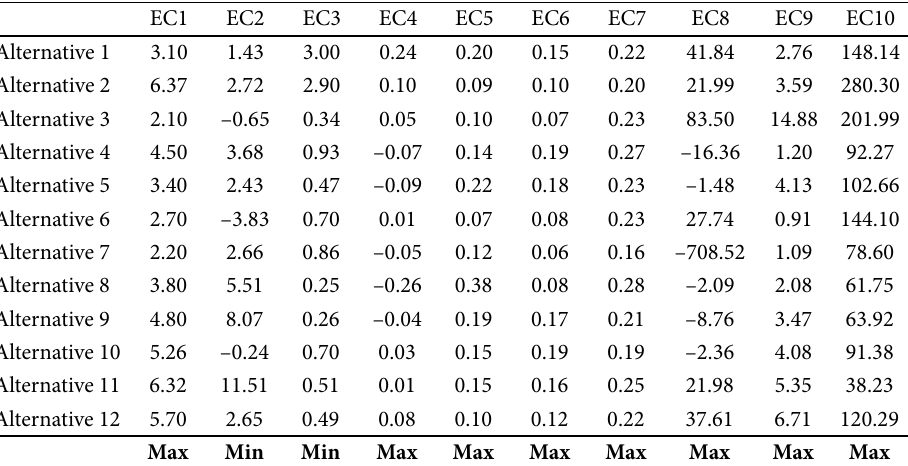
table 13. Predefined classifications with varying correlations between two decision maker Alternatives DM1